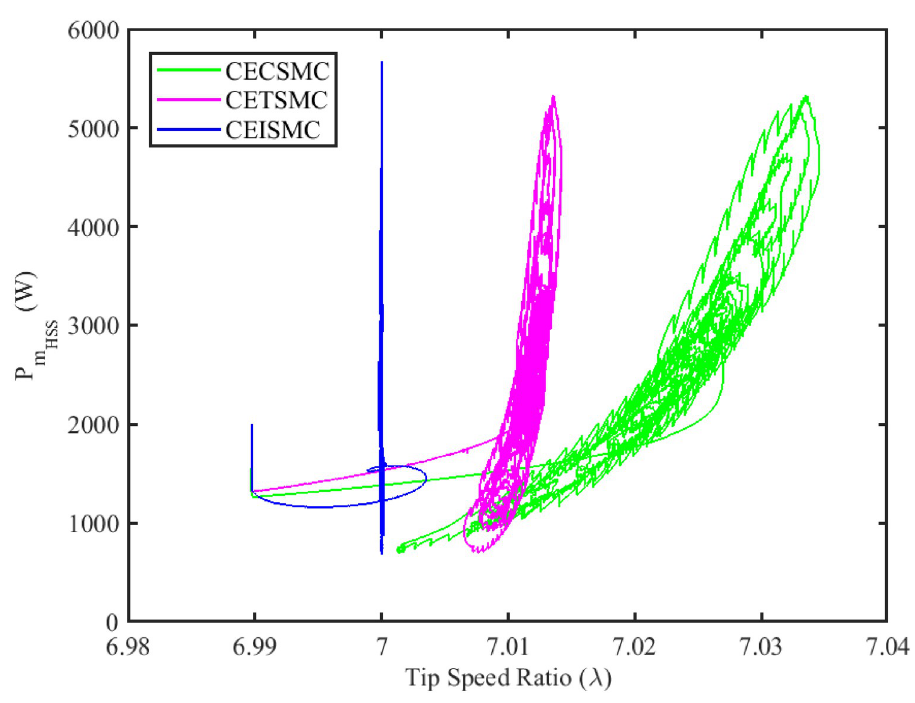
Fig 6. Tip speed ratio versus high speed shaft power.